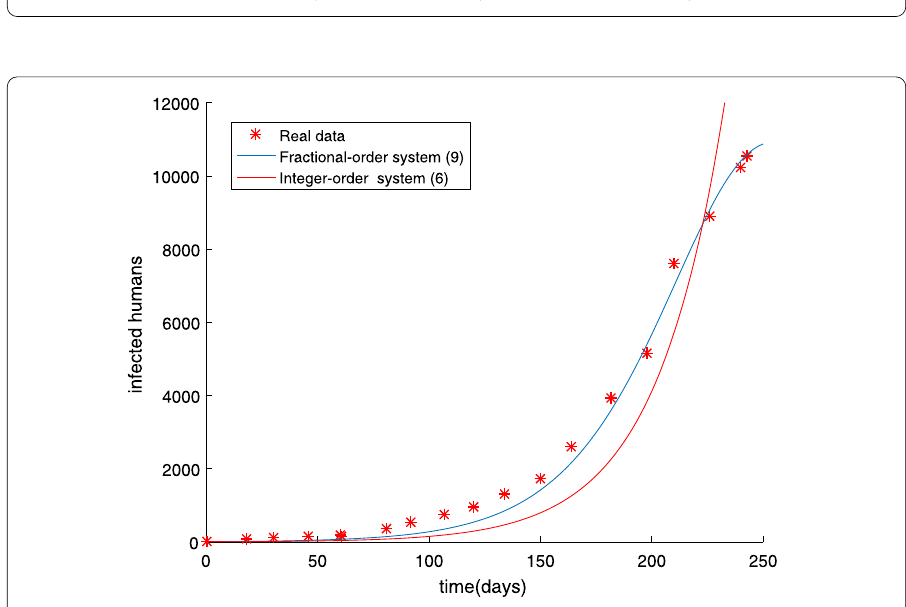
Figure 3 The fitting results of SEIR integer-order Ebola system (6) in which the root-mean-square relative error is g ( U ) = 1.0061 and fractional-order Ebola system (9) in which the root-mean-square relative error is g ( U ∗ ) = 0.4146 with real